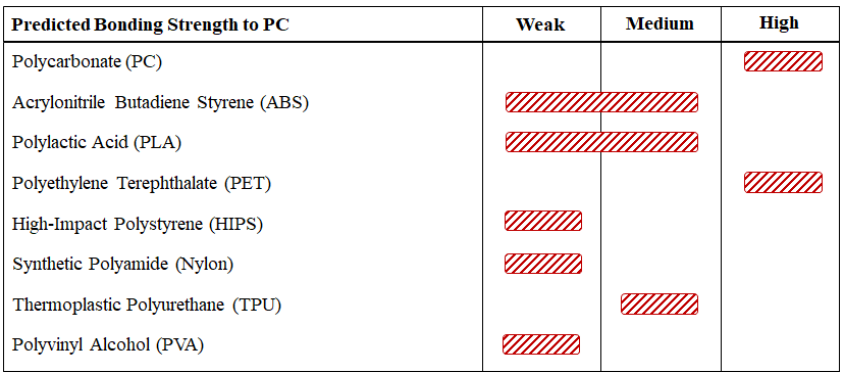
Figure 14. Predicted bonding with PC print bed for each polymer.